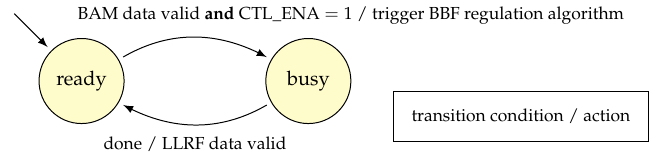
Figure 10. State diagram showing the effect of CTL_ENA flag on regulator state transitions.